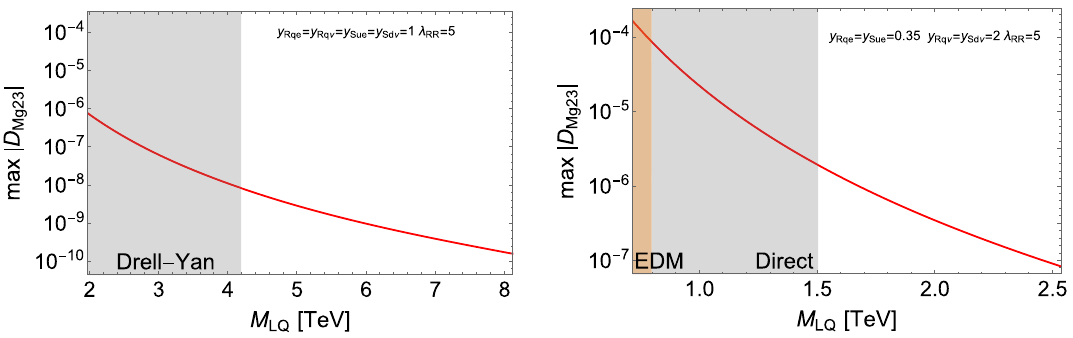
Fig. 2 Maximum value of the D parameter in 23 Mg (red line) possible in the model with two leptoquarks R 2 and ˜ R 2 for two particular choices of the leptoquark Yukawa couplings and for the scalar mixing param- eter λ RR = 5. Left: For | y Sd ν | = | y Sue | = | y Rqe | = | y Rq ν | = 1 the gray-shaded area (Drell–Yan) is excluded by pp → e + e − [43]. Due to the strong Drell–Yan bound on M the D parameter is suppressed below O ( 10 − 8 ) in the allowed parameter space. For these Yukawa cou- plings the EDM constraints are much weaker, M LQ (cid:2) 1 TeV. Right: For | y Rqe | = | y Sue | = 0 . 35 and | y Sd ν | = | y Rq ν | = 2, one can arrive